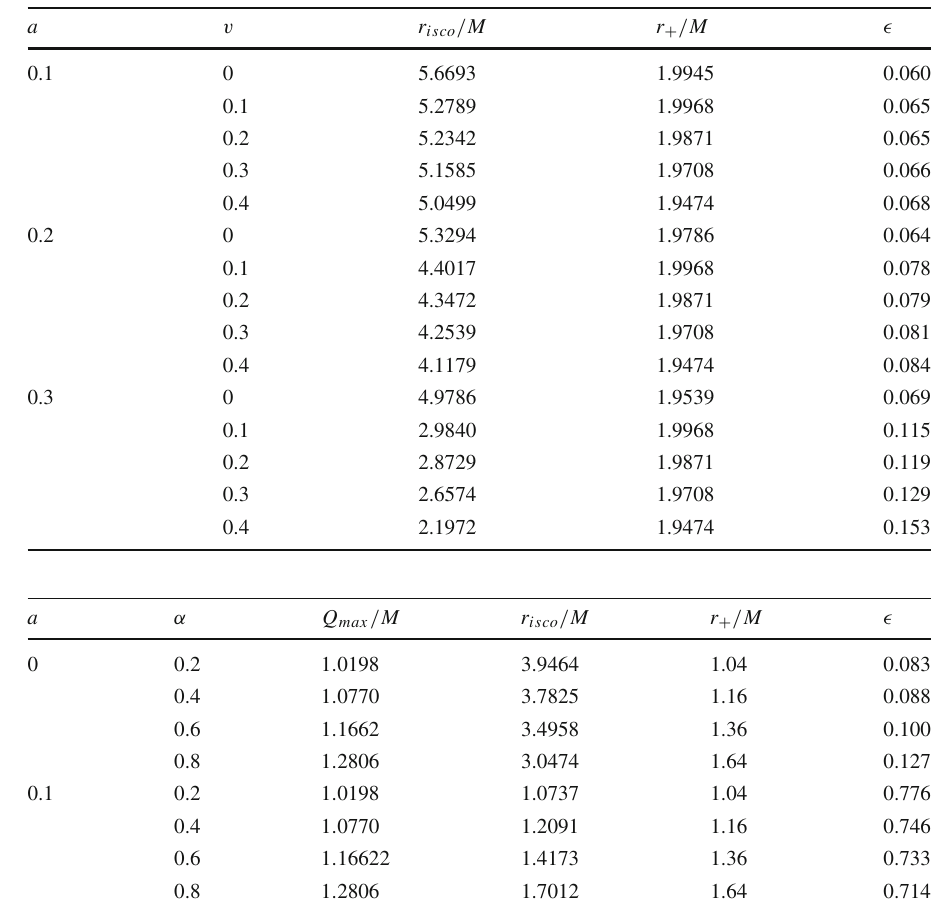
Table 2 The r isco of the accretion disk and efficiency for charged, slowly rotating dilaton black